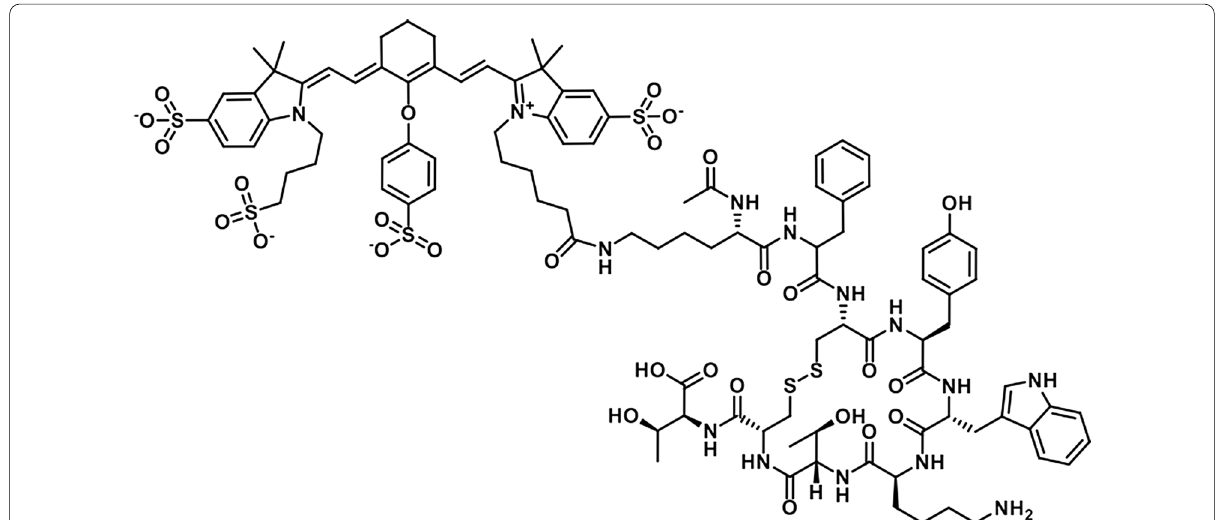
Fig. 1 Structure of Ac-Lys 0 (IRDye800CW)-Tyr 3 -octreotate